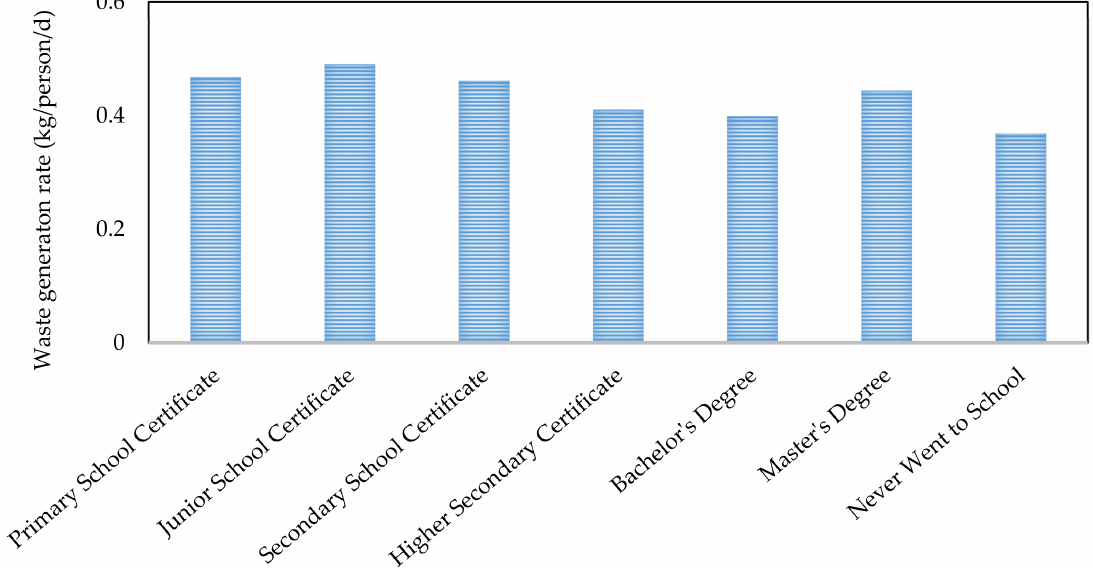
Figure 8. Waste generation rate with respect to educational status.